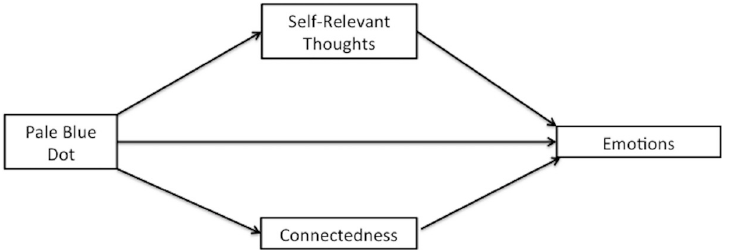
Fig 1. Conceptual model for indirect effects of connectedness and self-relevant thoughts on self-transcendent emotions (Study